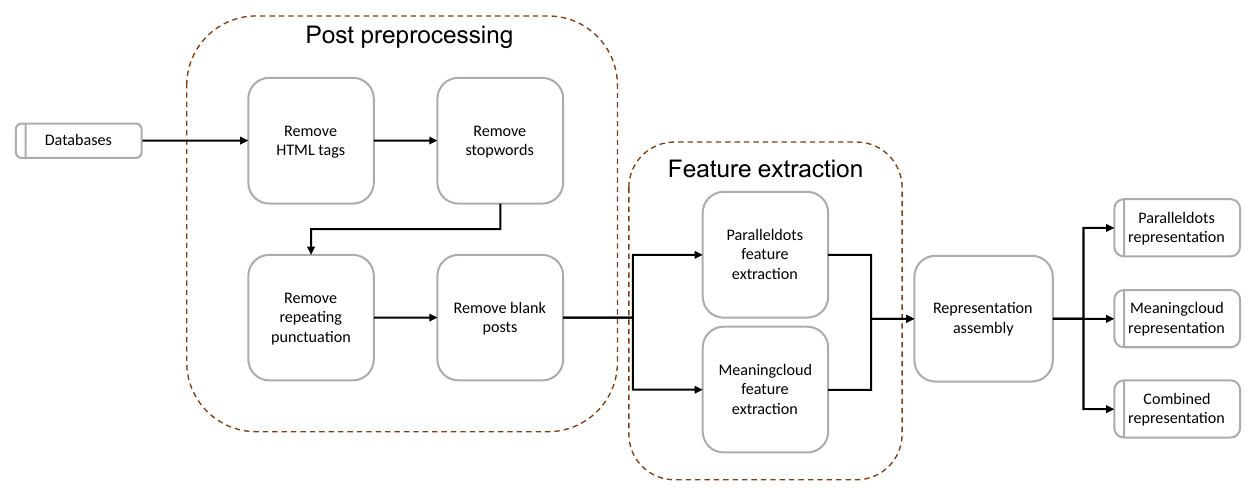
Figure 1. Flowchart of the process followed to obtain the representations used in the experimentation. leldots features with 23 different features, including the length of the post in words. The